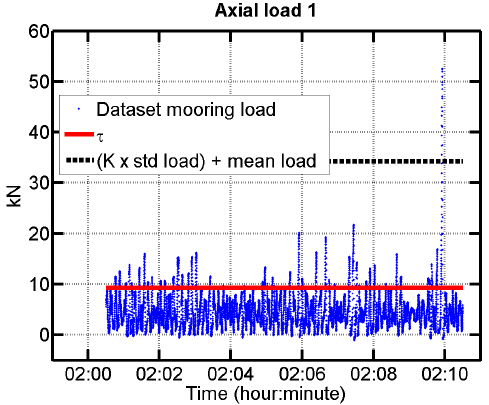
Figure 4. Example of a 10-min record of mooring load on line 1 at SWMTF showing the value during a storm (17 November 2010) and a comparison of the values with a load factor K and a minimum threshold τ .